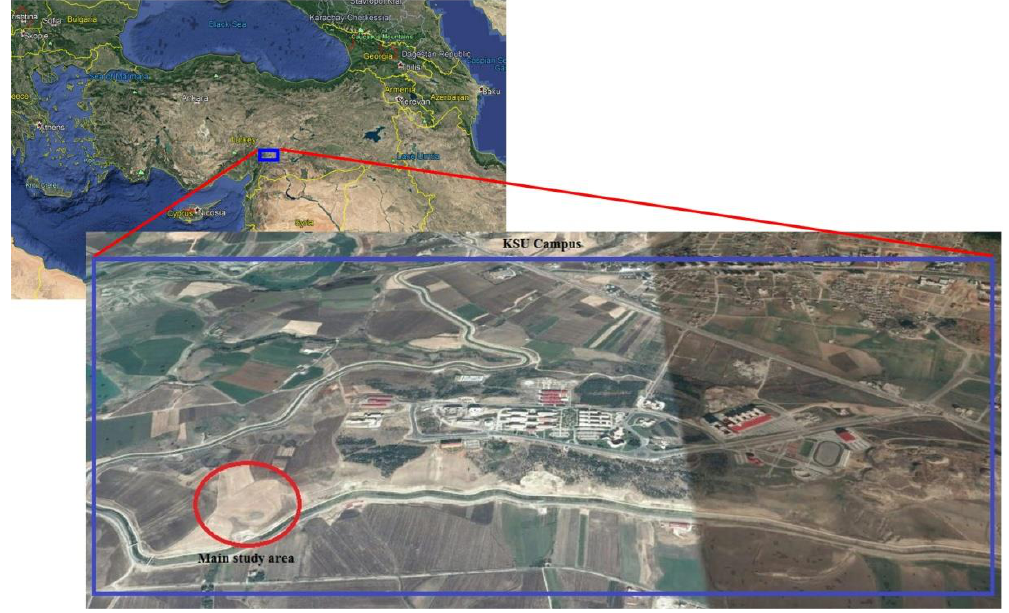
Figure1.Geographical location of the study